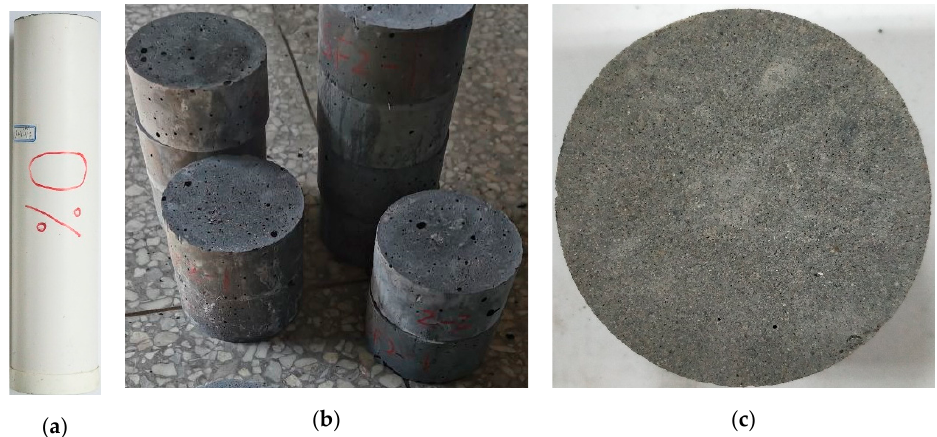
Figure 1. UHPC cylindrical specimen for dynamic test.